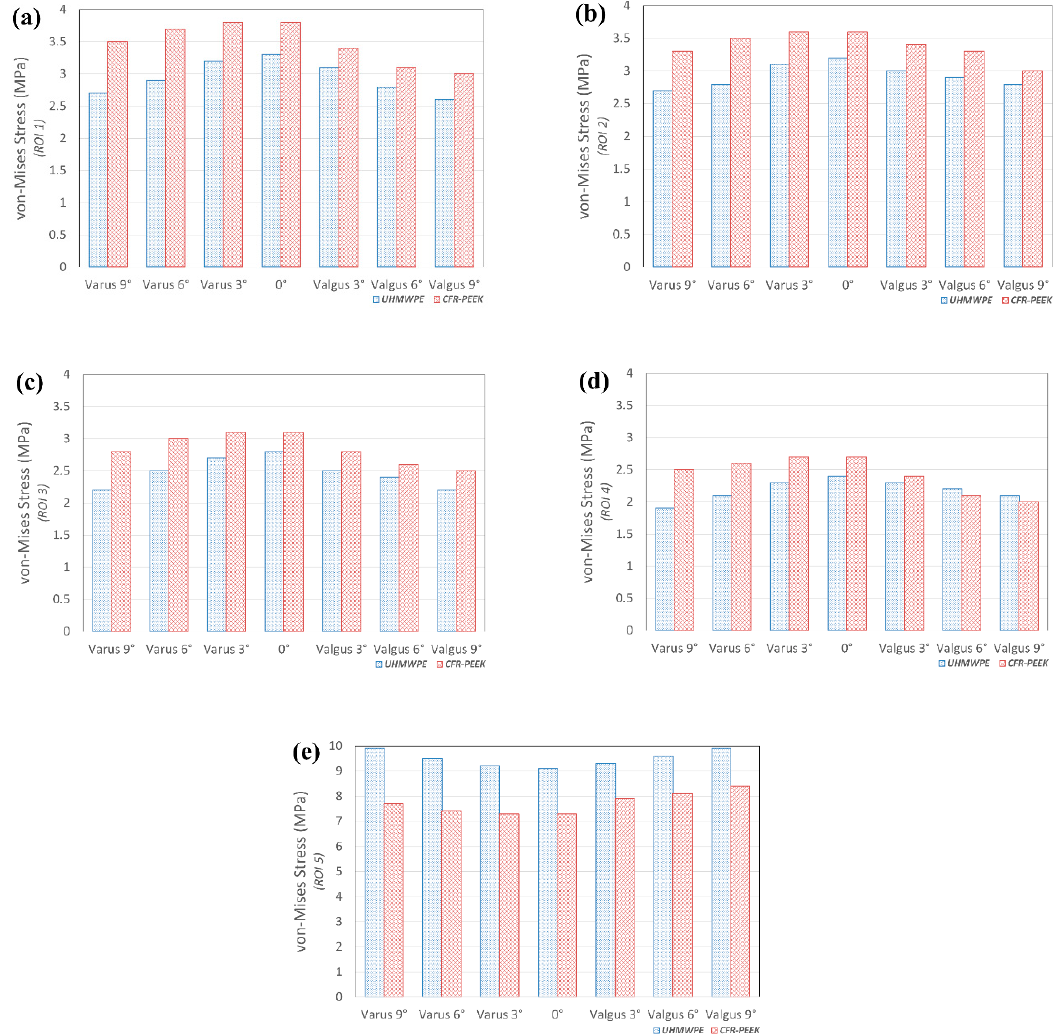
Figure 6. Comparison of von-Mises stress in ROI 1–5 in varus/valgus condition with respect to different tibial insert materials during gait cycle: ( a ) ROI 1; ( b ) ROI 2; ( c ) ROI 3; ( d ) ROI 4; and, ( e ) ROI 5.